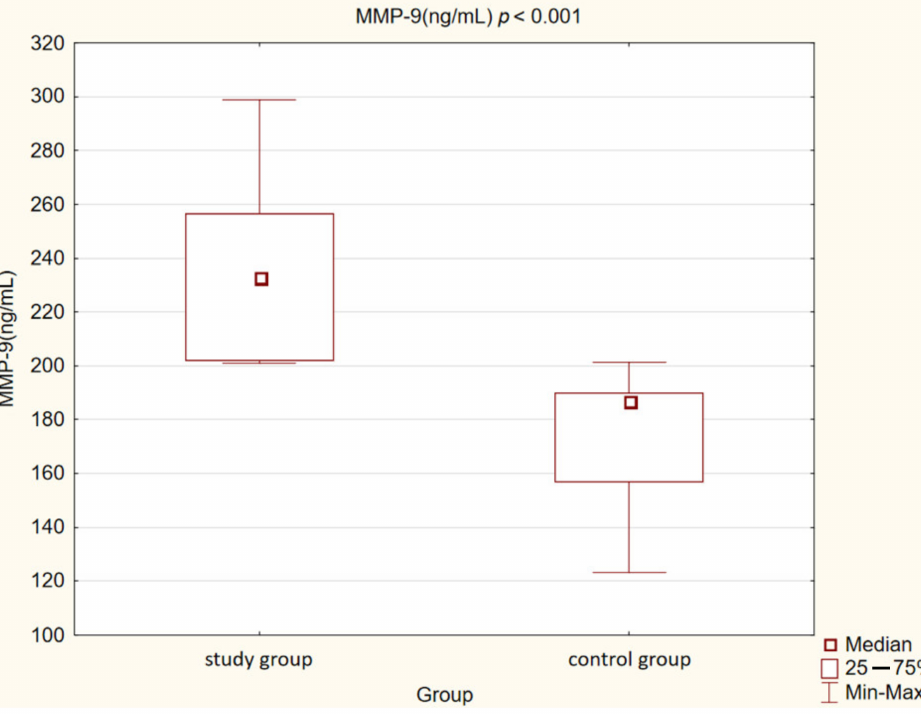
Figure 8. Concentration of metalloproteinase 9 (MMP-9) in study and control